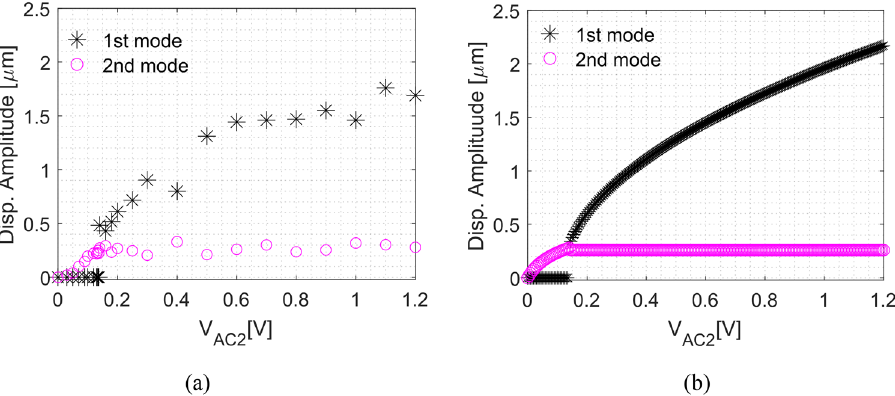
Figure 7. Force-response curves of the 1st and 2nd modes of the micro portal frame at V DC2 = 54 V actuation with E2. ( a ) Experimental data obtained at 152.3 kHz. ( b ) Numerical simulations at 152.47 kHz. The chosen frequencies of curves ( a ) and ( b ) are due to the equivalence of the response at Fig. 6. The force-response curves show the saturation of the 2nd mode around V AC2 = 140 mV, and all the extra vibration energy is transferred to the 1st mode.